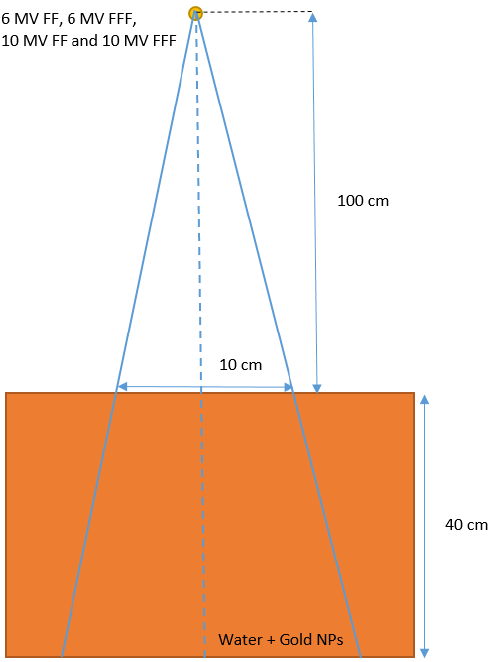
Figure 2. Schematic diagrams (not to scale) showing the heterogeneous phantom used in Monte Carlo simulations. The dimensions of the phantoms were equal to 40 × 40 × 40 cm 3 . The phantoms were irradiated by the 6 MV FF, 6 MV FFF, 10 MV FF and 10 MV FFF photon beams with field size equal to 10 × 10 cm 2 . The source-to-surface distance (SSD) was equal to 100 cm.